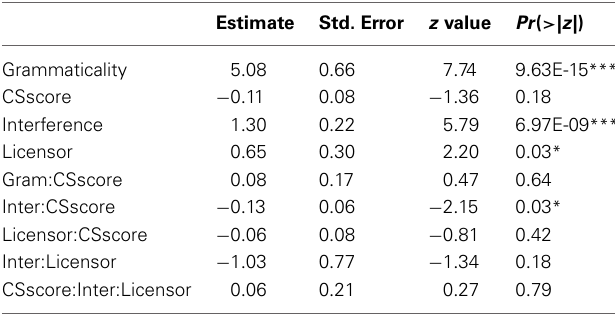
Table 3 | NPI licensing acceptance rate: fixed effects from the mixed effect logistic model for the overall